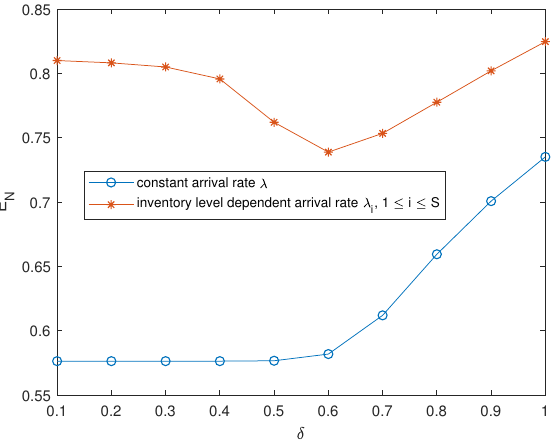
Figure 9. Effect of δ on E N